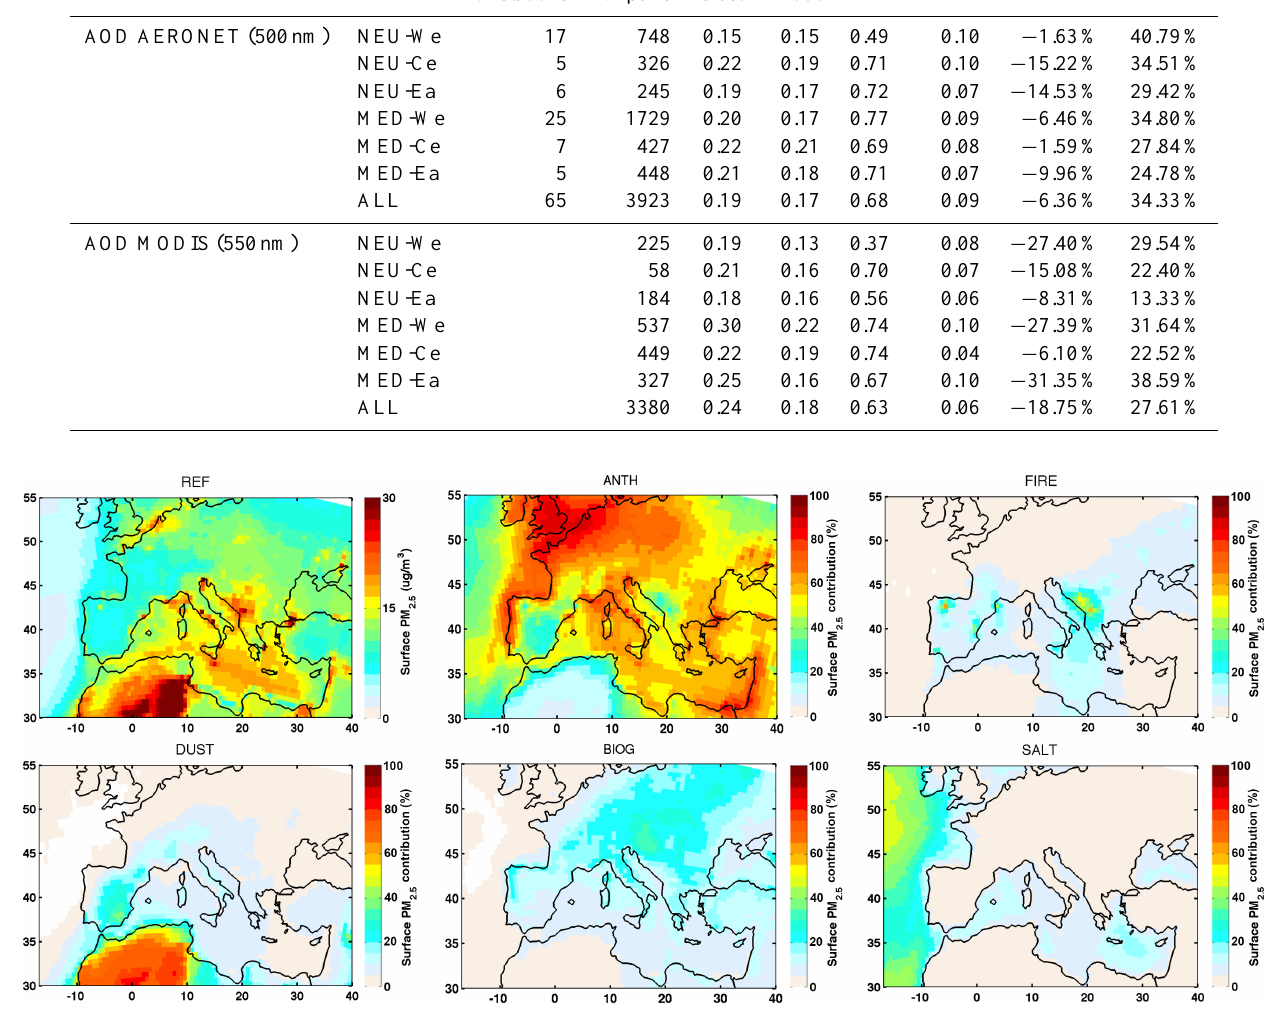
Figure 8. Relative contribution of each source type (i.e., the baseline simulation minus the sensitivity simulation where the respective source has been eliminated) to the simulated surface PM 2 . 5 , averaged over the period (1 June to 31 August 2012). The top left represents the reference surface concentration over the same